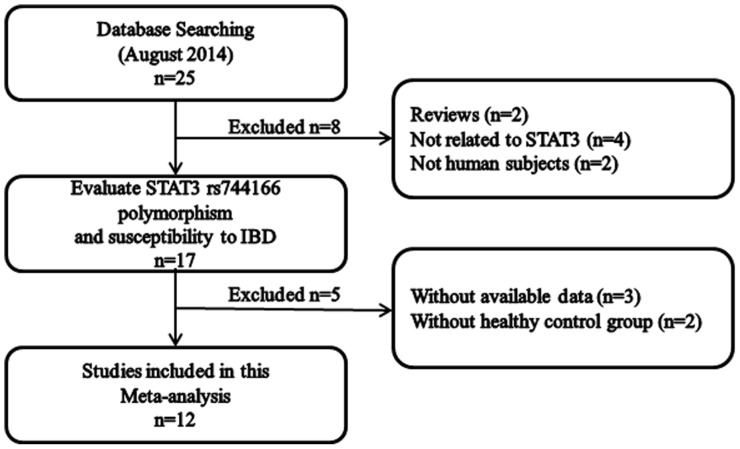
The screening process of studies.